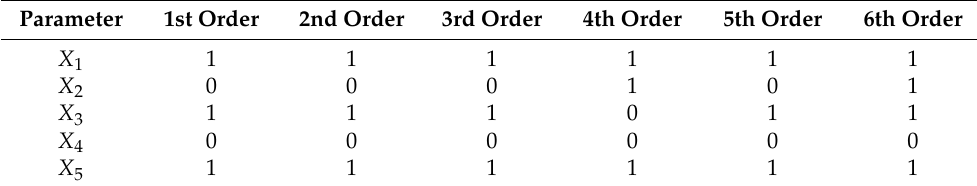
Table 6. Significance analysis of parameters that needed to be